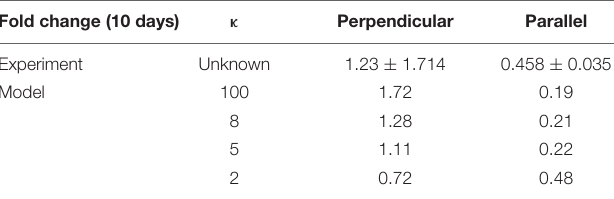
TABLE 6 | The fold change of cells a 0–10% cyclic strain when seeded on structured constructs aligned perpendicular or parallel to strain.